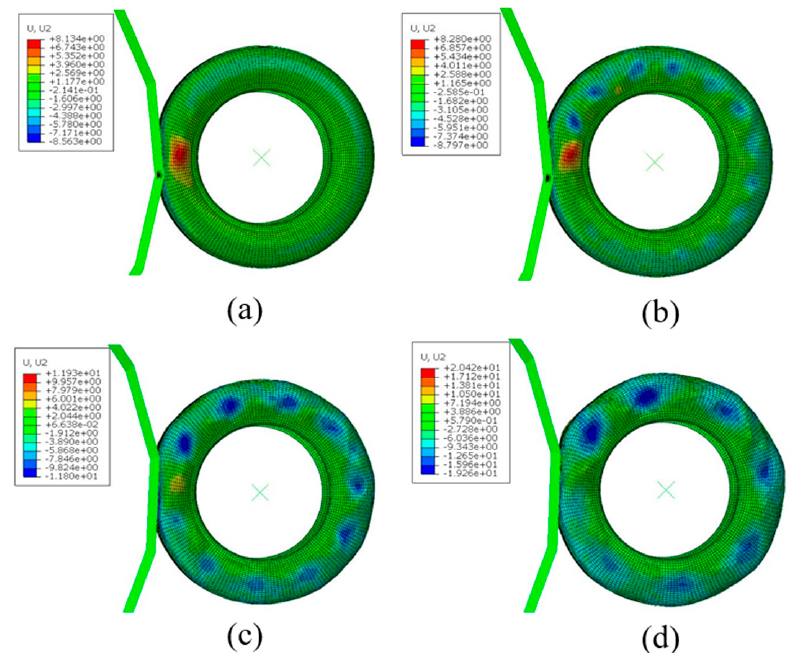
Figure 14. Strain field of aircraft tire at different speeds: ( a ) 130 km/h, ( b ) 150 km/h, ( c ) 170 km/h, ( d ) 190 km/h.